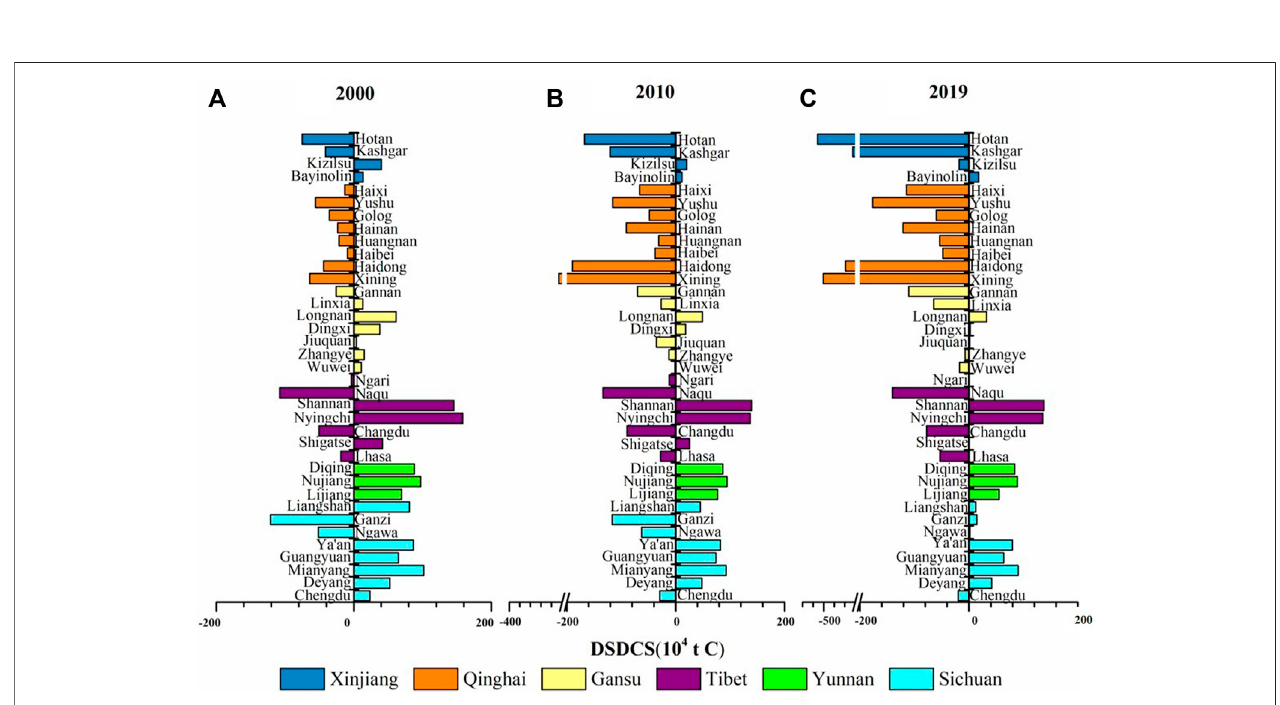
FIGURE 5 | DSDC changes in all cities in 2000 (A) , 2010 (B) , 2019 (C) .